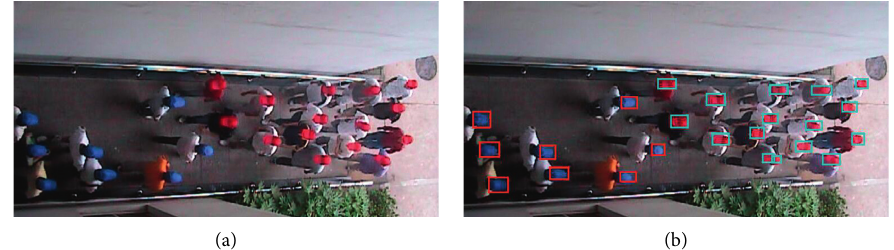
Figure 7: The images of another pedestrian flow experiment under open boundary conditions. It was conducted at 2015. (a) The original image; (b) the results detected by our Yolo v3